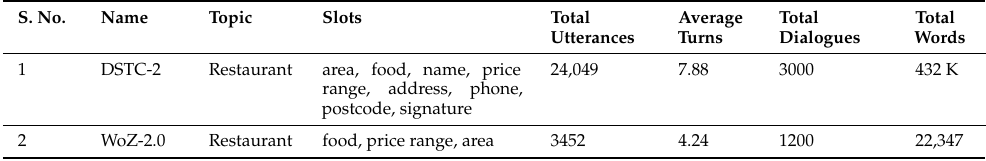
Table 2. Statistics of Used